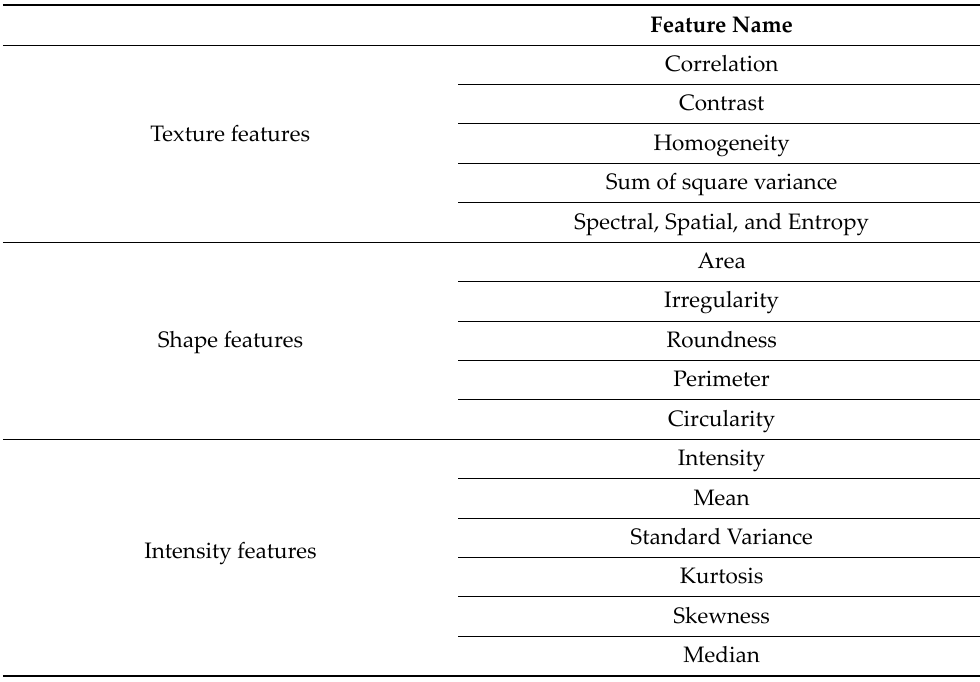
Figure 3. Machine Learning—CNN for classification. Table 2. List of extracted low‑level features.